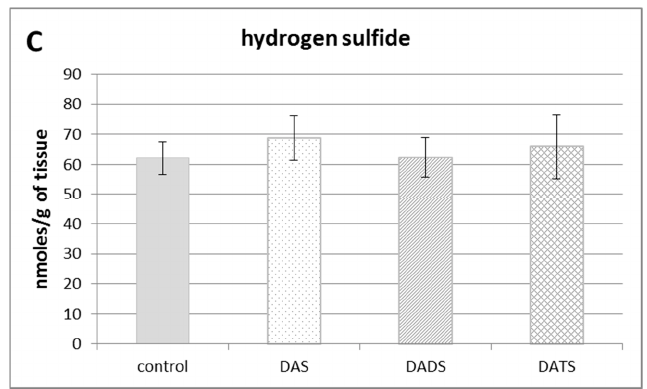
Figure 1. The effect of garlic-derived allyl sulfides (DAS, DADS and DATS) on the level of various reactive sulfur species: total sulfane sulfur ( A ); bound sulfur ( B ) and free hydrogen sulfide; H 2 S ( C ). Data represent the means of six animals in each group ± SD and are expressed as nmoles per 1 g of wet weight. Each assay was performed in triplicate. Statistically significant differences were determined by ANOVA followed by the Fisher test. * Significantly different from control group ( p < 0.05).